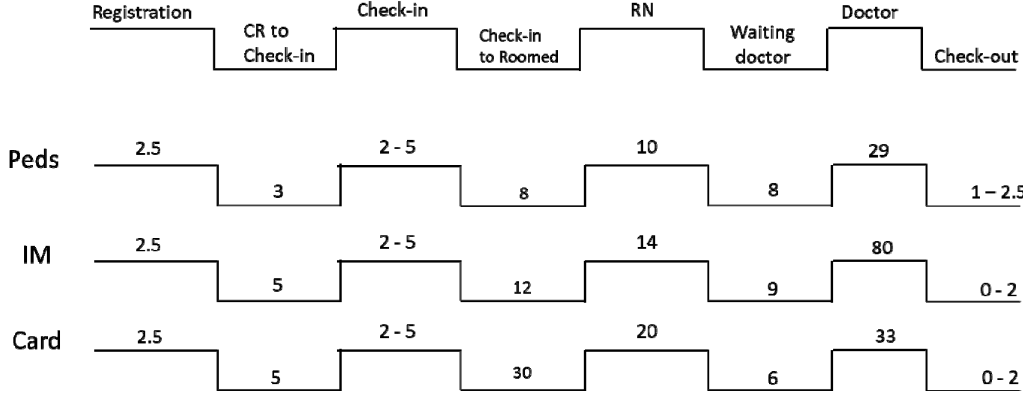
Figure 2. Current process performance times (in